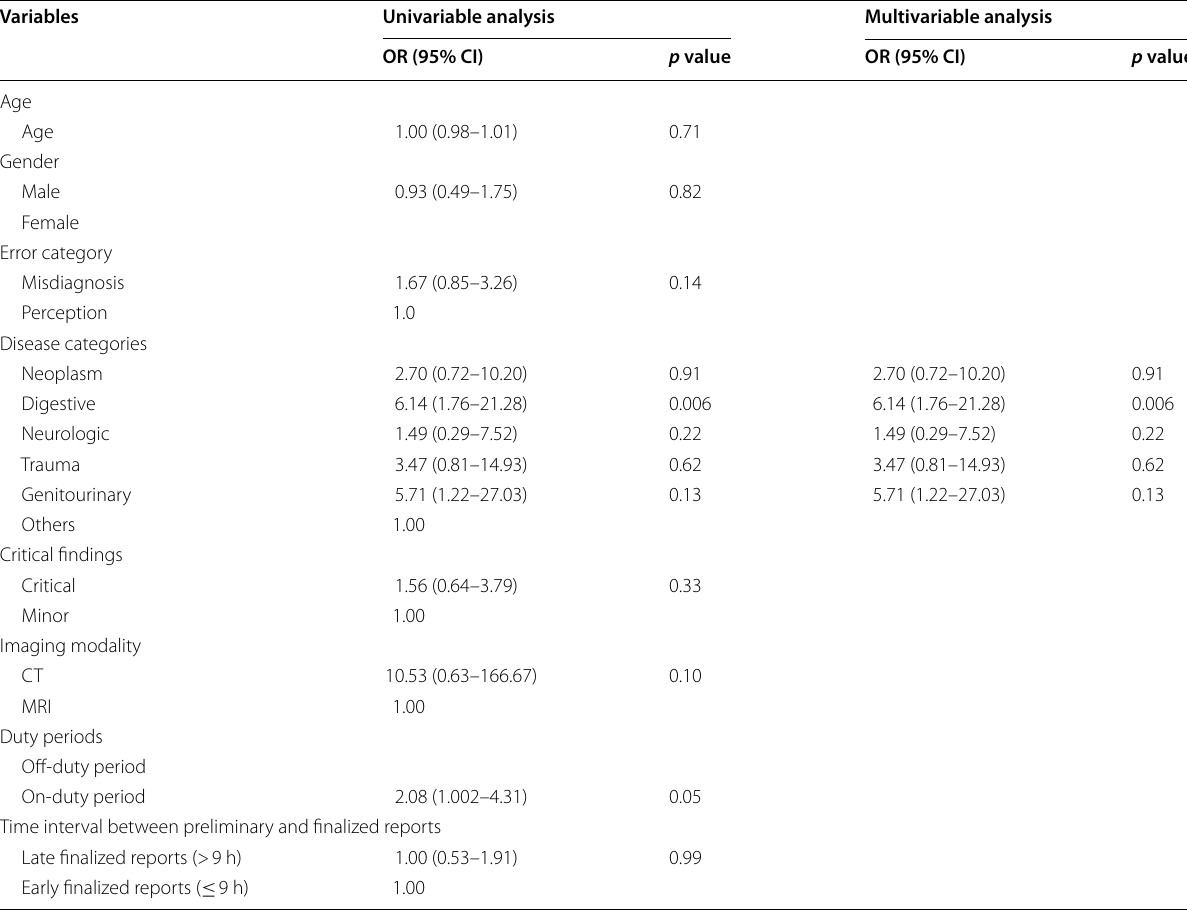
Data are shown as odds ratios with 95% confidence intervals in parentheses CT computed tomography, CI confidence interval, MRI magnetic resonance imaging, OR odds